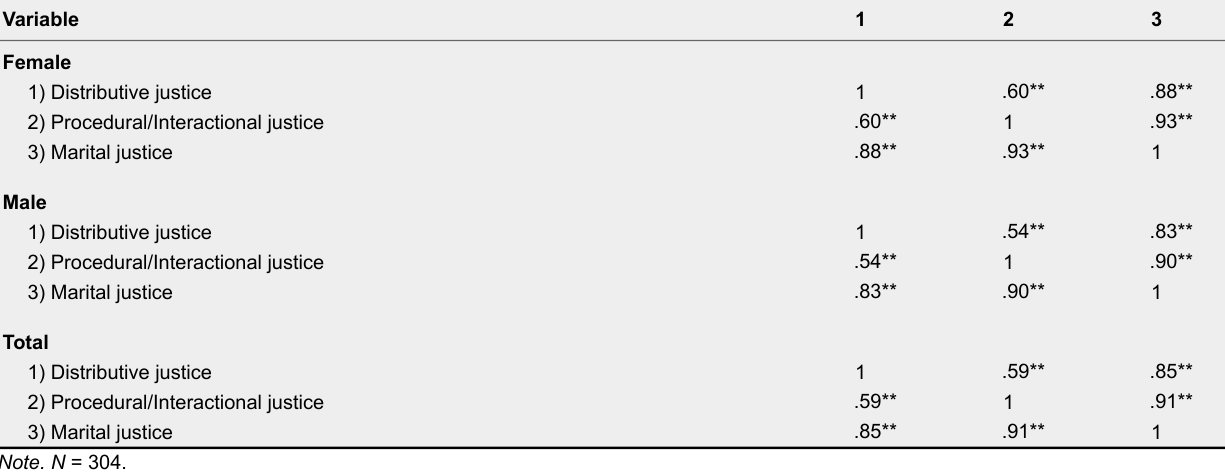
Pearson’s Correlation Coefficients between Subscales of Marital Justice Scale (MJS) With Each Other, and With Total Score of MJS